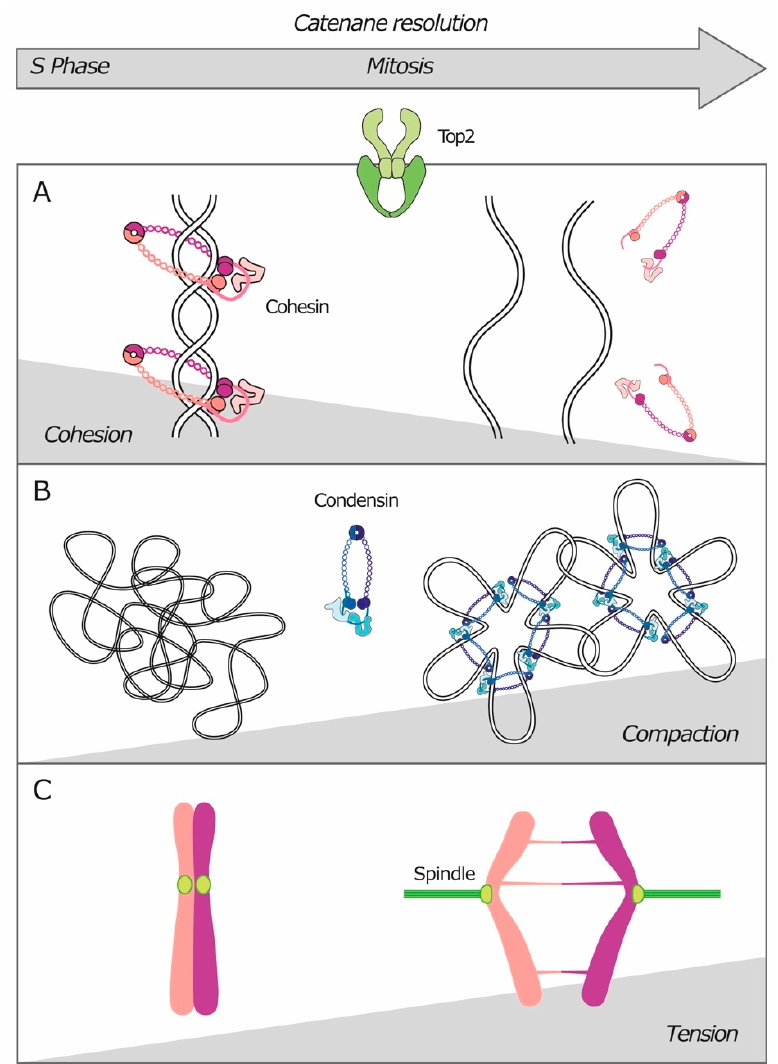
Figure 5. Chromatid individualization and separation aid the resolution of sister chromatid intertwines. During mitosis, ( A ) cleavage of cohesin complexes, ( B ) condensin-mediated compaction, and ( C ) chromatid separation by the mitotic spindle provide directionality to the reaction catalyzed by Top2, favoring the resolution of DNA catenanes.